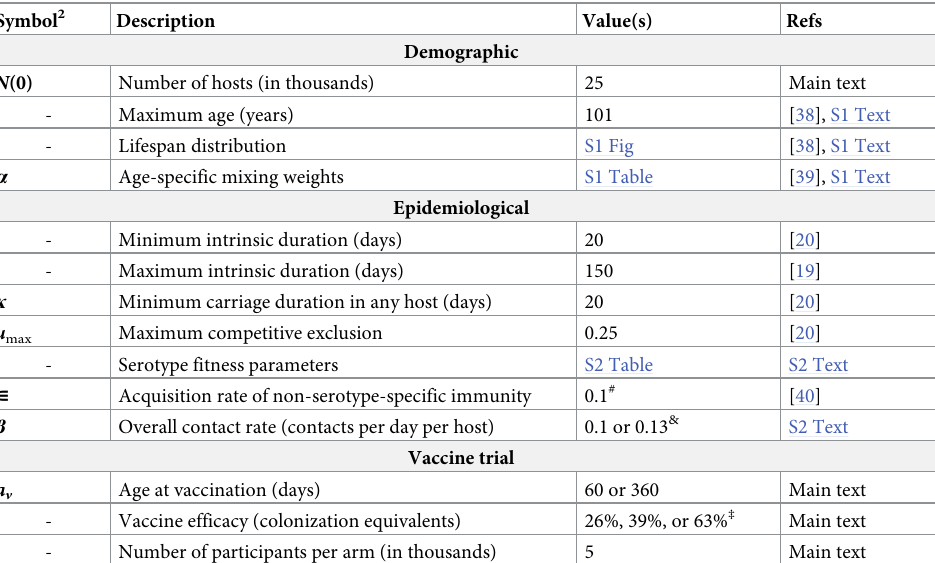
Table 1. Selected 1 model